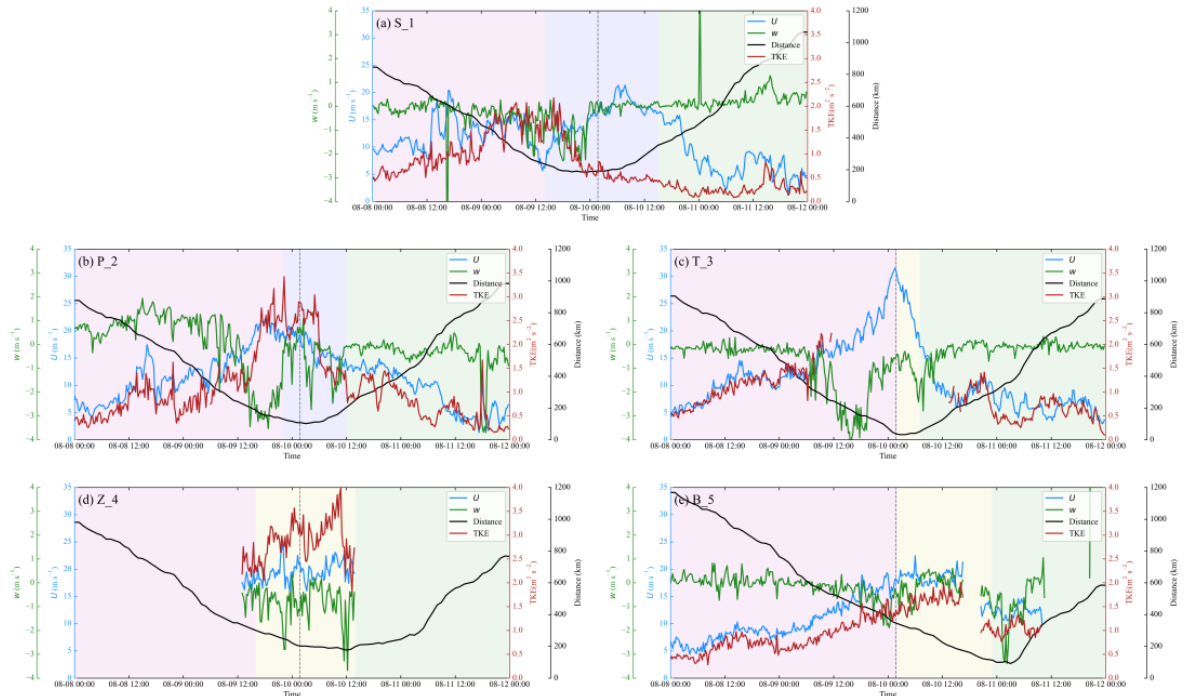
Figure 7. Time variation of mean U , mean w , mean TKE, and distance to typhoon center for five DWLs at altitudes of 70–200 m. ( a ) S_1, ( b ) P_2, ( c ) T_3, ( d ) Z_4, and ( e ) B_5. Backgrounds with different colors indicate that the stations are located at different quadrants relative to the typhoon center. The blue solid line represents U , the green solid line is w , the red solid line is TKE, and the black solid line is the distance from the station to the typhoon center. The black dashed line is the time of typhoon landfall. Color shading indicates the quadrant, as in Figure 1b.